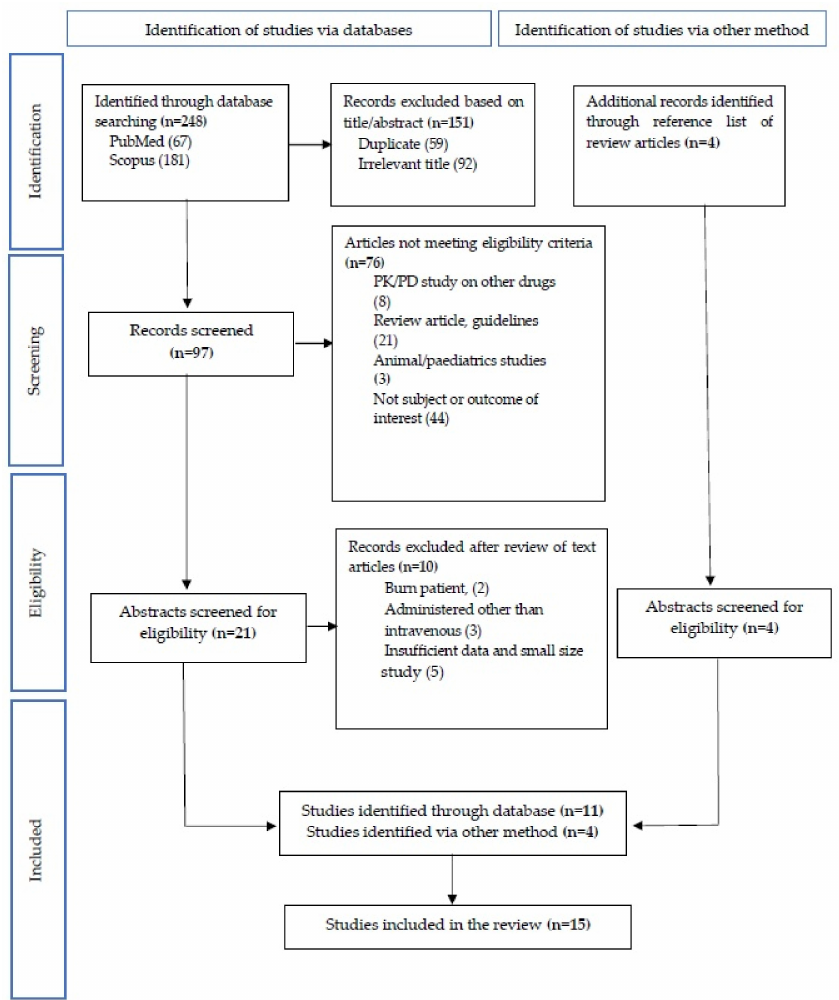
Figure 1. Studies identification and